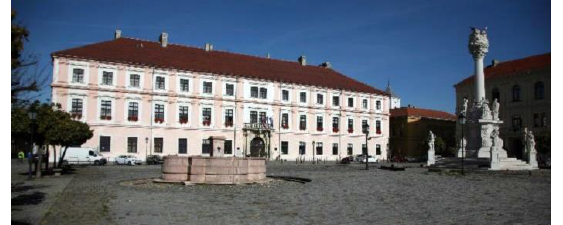
Figure 3: The Palace of the Slavonian General Command in Osijek in northern Croatia. (Stober et al. , 2018)